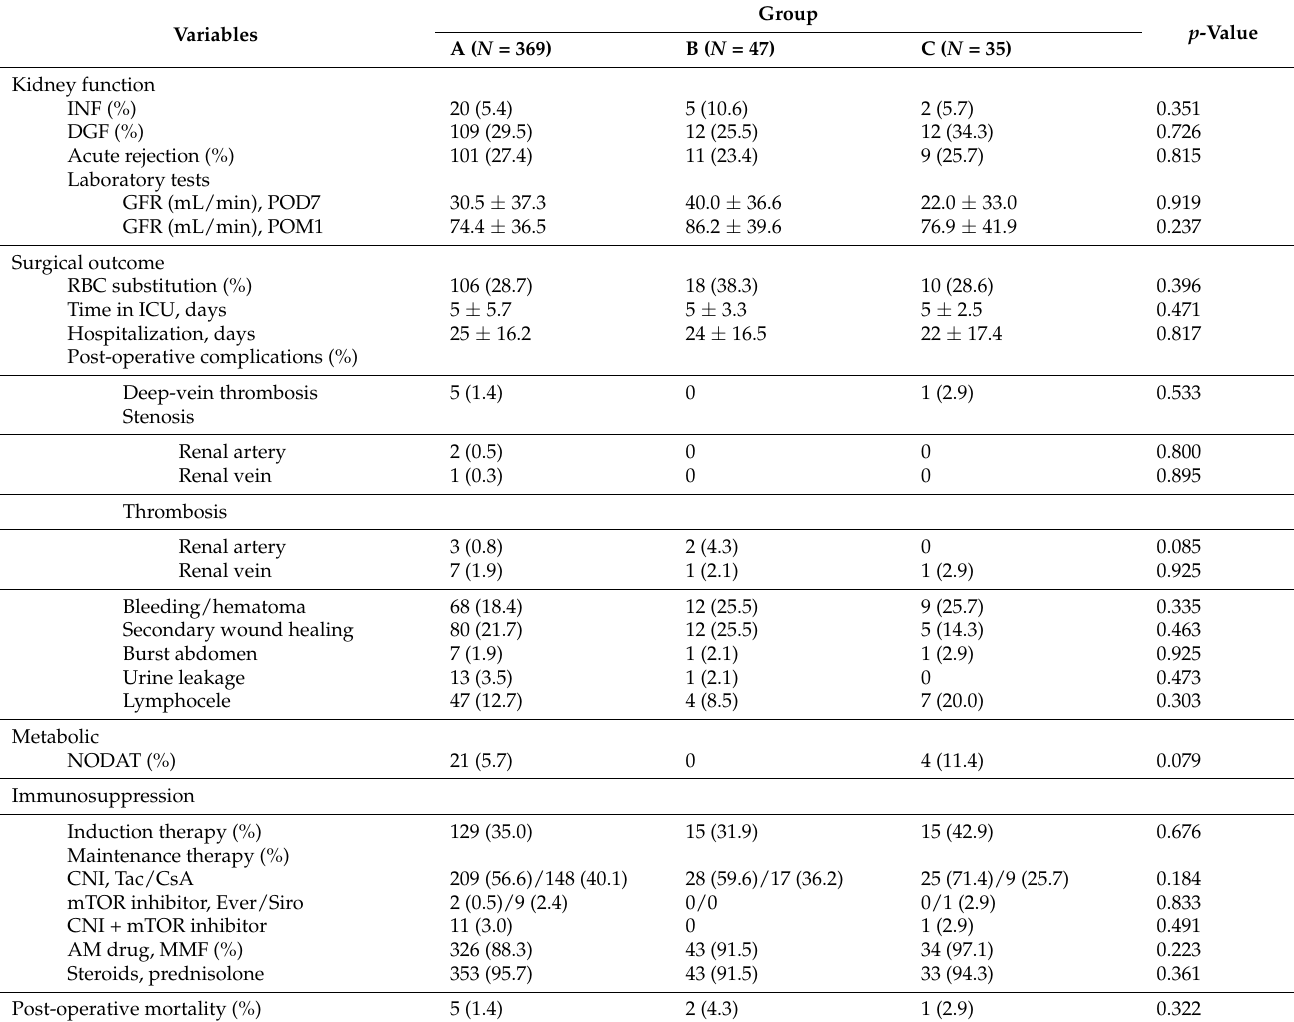
Table 2. Post-operative outcome parameters and immunosuppression after deceased donor kidney transplantation.